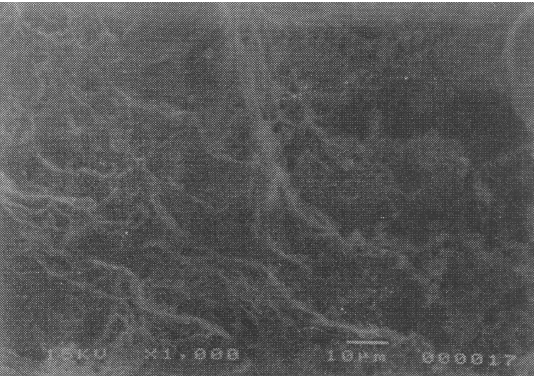
Fig. 16. Scanning Electron Microscopic (SEM) fractography of the failed plate; dimple features show ductile